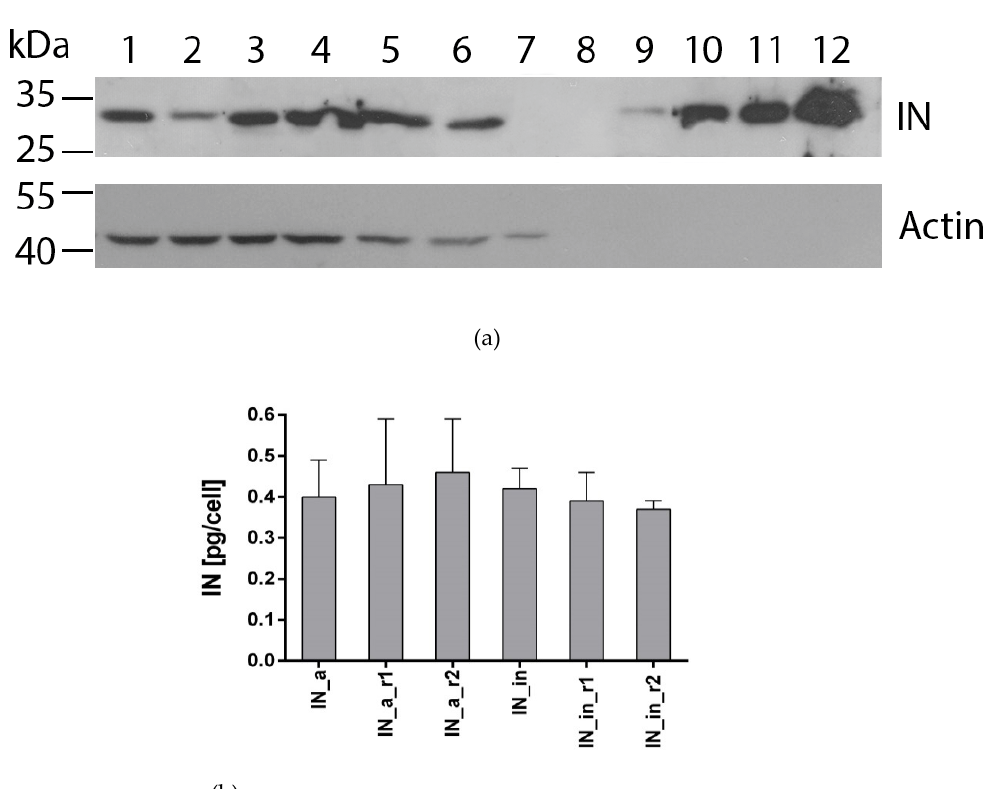
Figure 2. Expression of IN variants in eukaryotic cells. Western blotting of the lysates of HeLa cells transiently trans- fected with the pVaxIN_a (lane 1), pVaxIN_a_r1 (lane 2), pVaxIN_a_r2 (lane 3), pVaxIN_in (lane 4), pVaxIN_in_r1 (lane 5), pVaxIN_in_r2 (lane 6), or empty vector pVax1 (lane 7); Page Ruler Prestained Protein Ladder (Fermentas) (lane 8); recombinant IN of LAV/BRU strain of HIV-1 loaded in the amounts of 0.5, 2.5, 5, and 10 ng/well (lanes 9 to 12, respectively) ( a ); average amount of IN variant expressed per transfected HeLa cell assessed by ImageJ ( b ). Western blotting was done with murine monoclonal anti-IN antibody (IN-2 #ANT0071, Diatheva, Cartoceto, Italy), and blots were stripped and re-stained with the monoclonal anti-actin antibodies. ( b ) The results of two independent runs, each done in duplicate, mean ± SD. Levels of expression of IN variants did not differ ( p > 0.1; Kruskal–Wallis